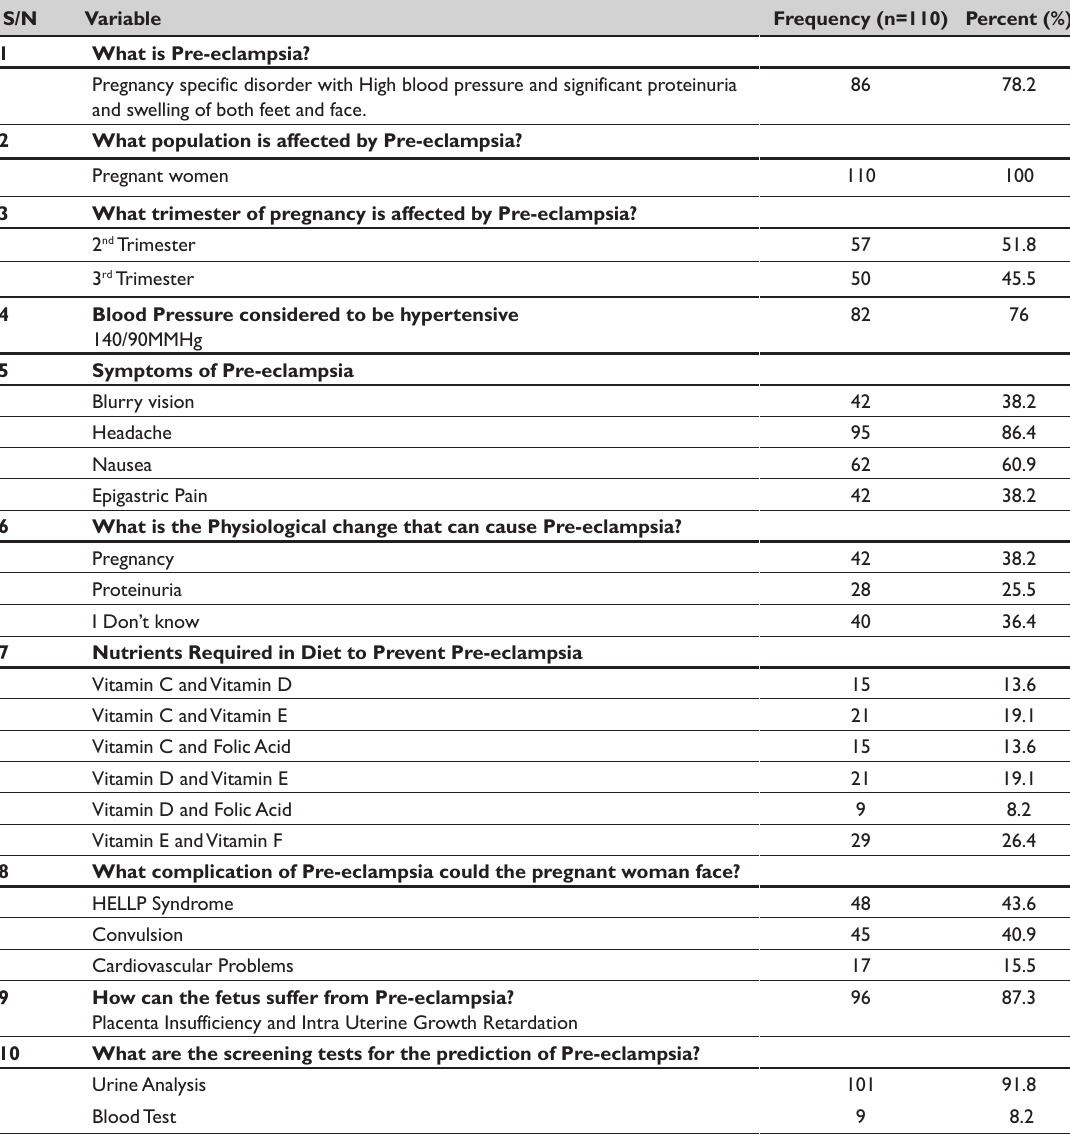
Table 3: Frequency Distribution of Respondent’s Knowledge on Pre-eclampsia S/N